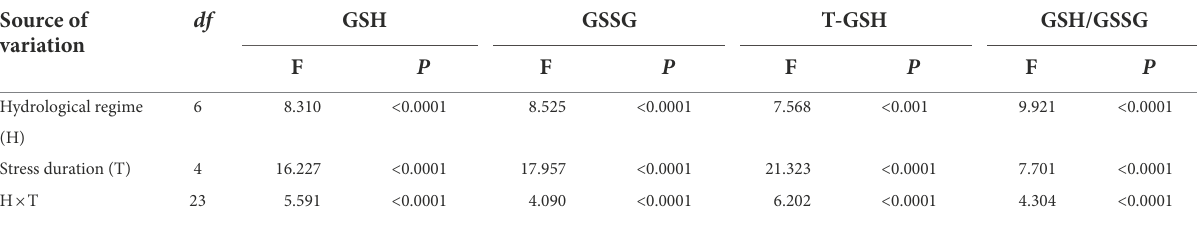
TABLE 3 Results of linear mixed models examining the effects of hydrological regime, stress duration and their interactions on the glutathione in Deschampsia caespitosa. Source of df GSH variation